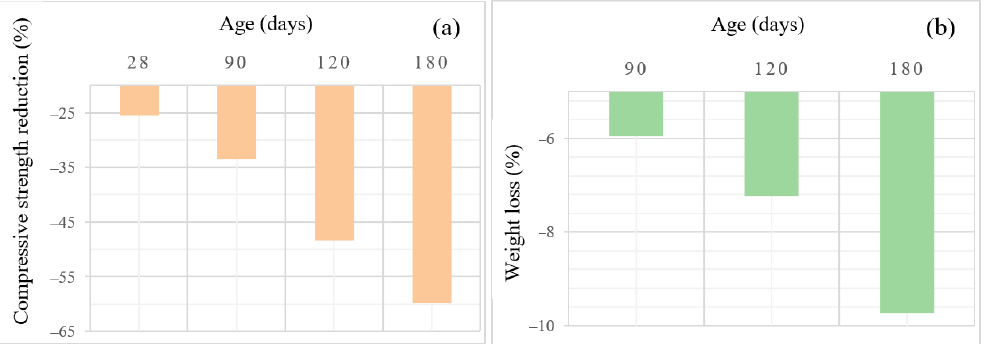
Figure 13. ( a ) Compressive strength reduction and ( b ) weight loss of OPC samples after exposure to acid for up to 6 months.